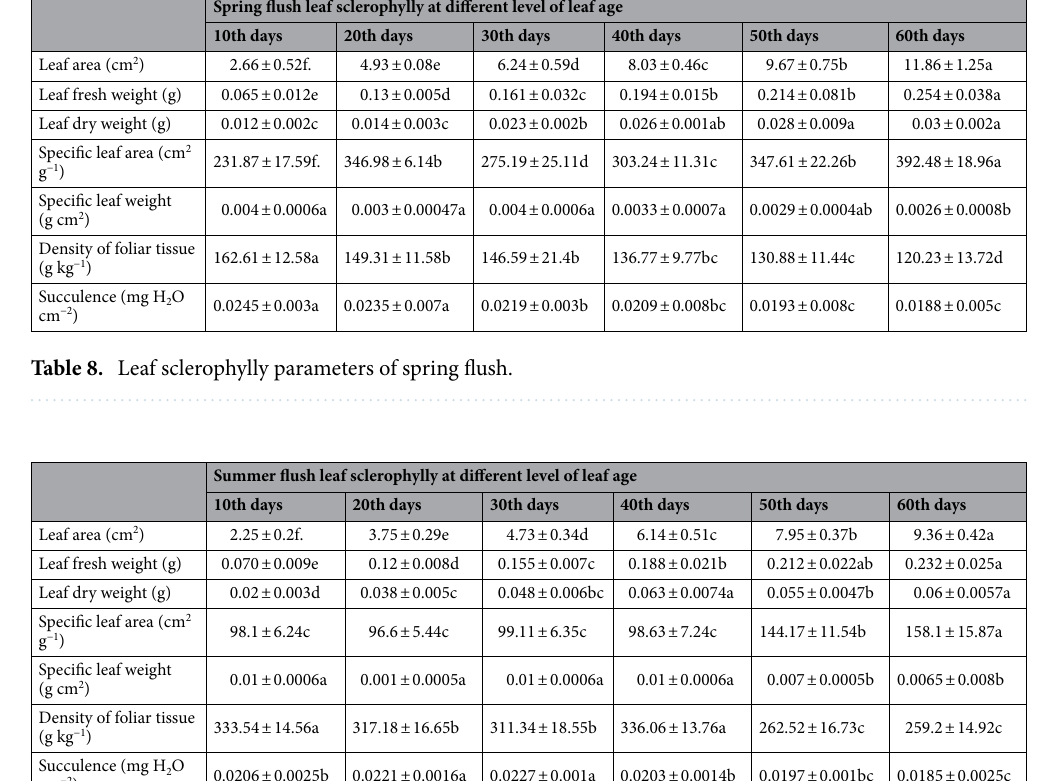
Spring flush leaf sclerophylly at different level of leaf age